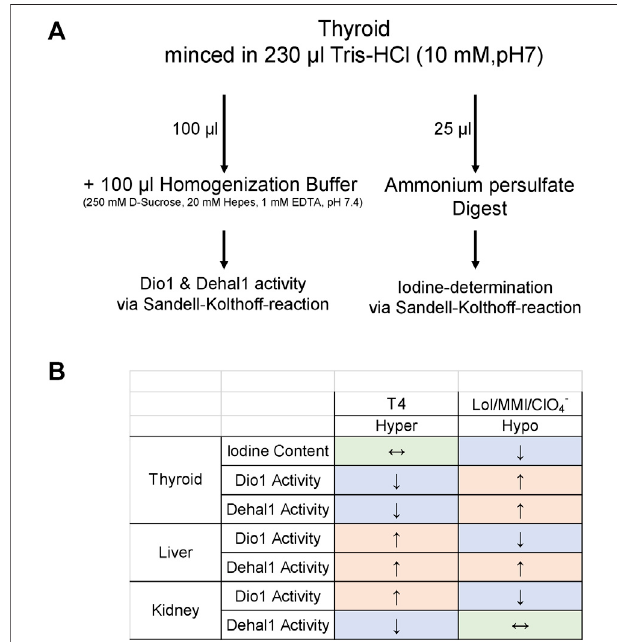
FIGURE 3 | Organ-speci fi c patterning of biomarkers; By utilizing a respective pilot protocol for sample preparation (A) and measurement, a patterning of readouts (B) including thyroidal iodine content, Dio1 and Dehal1 from thyroid, liver and kidney was generated. The suggested patterning of these readouts appears to be suitable to de fi ne situations of hypo- and hyperthyroidism. Its application and veri fi cation in future studies would be helpful to determine local TH status and to observe disruption of the TH system in toxicological studies. All readouts are accessible via Sandell- Kolthoff-based assays as uni fi ed readout platform